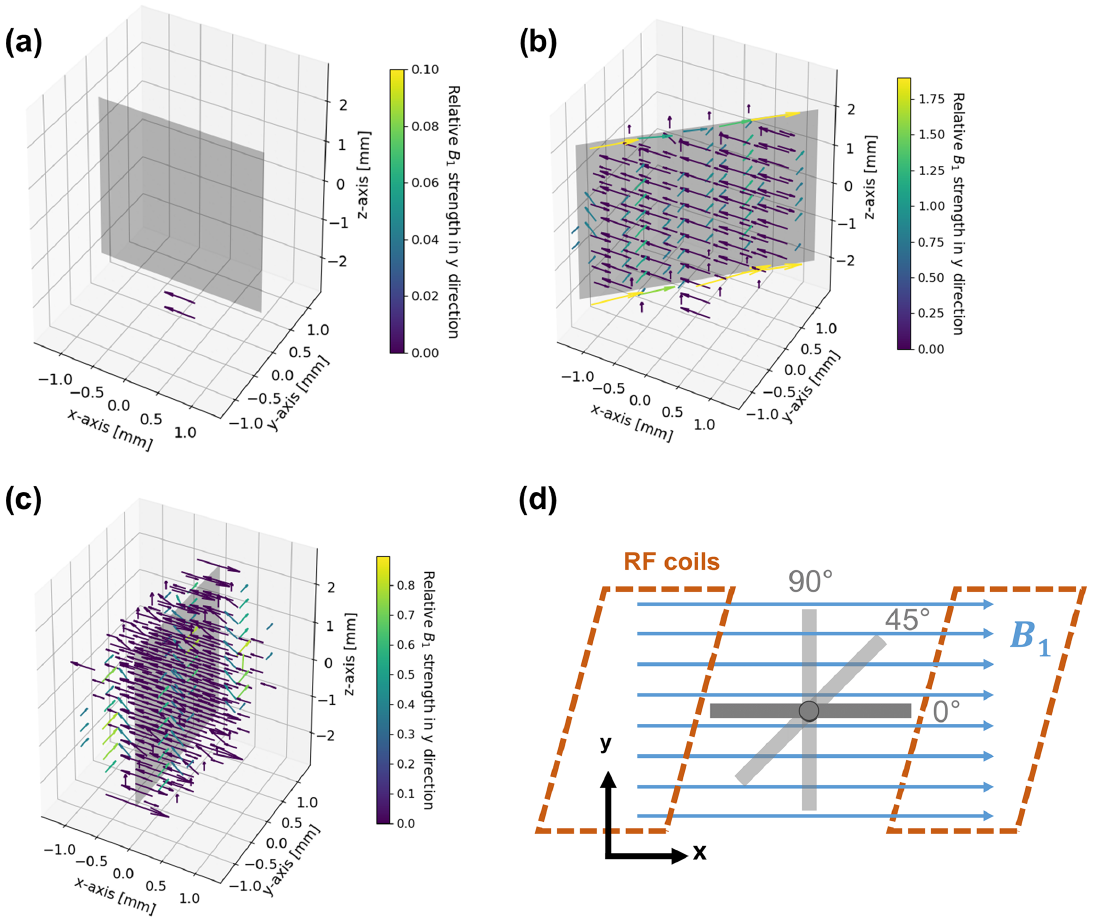
Figure 4. B 1 field simulation in the proximity of the metal electrode for angles of 0 ◦ (a) , 45 ◦ (b) , and 90 ◦ (c) between the direction of the incoming RF field and the electrode surface, and geometry and arrangement of the metal electrode in relation to the B 1 field in the simulations (d) . The incoming RF field points towards the positive x axis. The vectors represent the deviations in field strength and direction compared to the undistorted RF field. Deviations smaller than B 1 /e are not shown in order to increase clarity. For a better visibility of phase deviations, the vectors are color coded according to their relative field strength in the y direction compared to the incoming field amplitude. Note that all figures have individual color-bar ranges. No distortion is present for a parallel (0 ◦ ) orientation of the RF field and electrode. The angled (45 ◦ ) and perpendicular (90 ◦ ) orientations cause major distortions in immediate proximity to the electrode, which diminish at a distance of